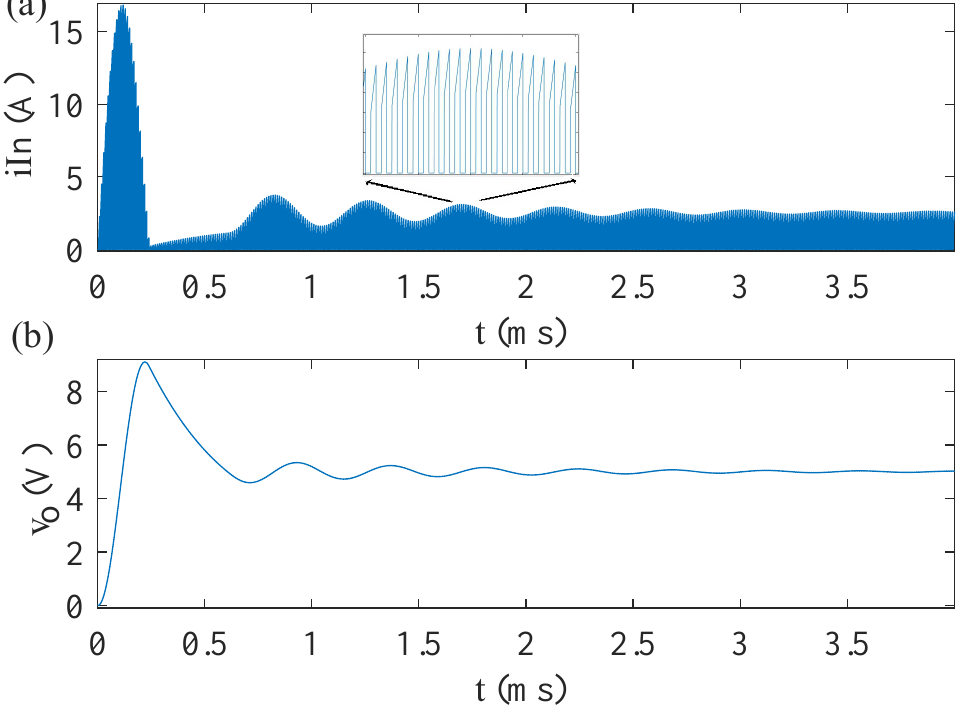
Figure 3. ( a ) Input current, iIn , ( i L when Q : ’ON’); and ( b ) output voltage, v o , ( v C ) for the golden HIL model of the proposed buck